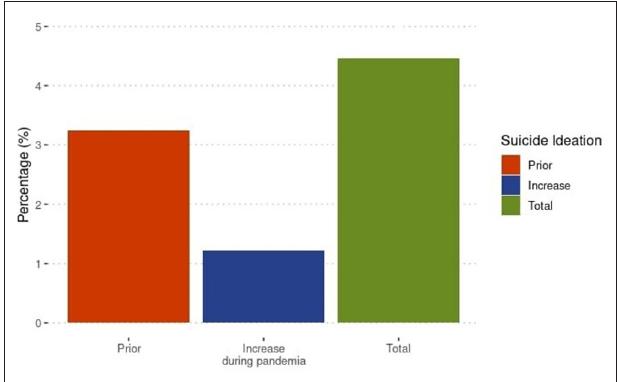
FIGURE 1 | Results before and after of